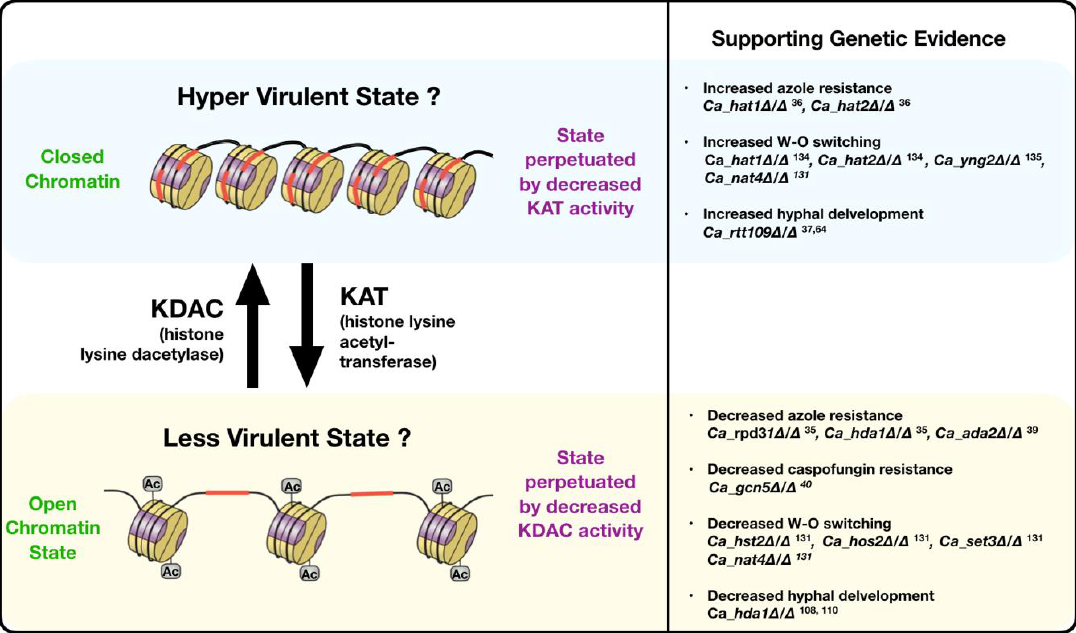
Figure 3. Simplified model of the role of histone acetylation in C. albicans virulence. A summary of the genetic studies in C. albicans that are consistent with a model whereby a decrease/loss in specific histone acetylation marks lead to a hypervirulent state, whereas an increase in histone acetylation is associated with the attenuation of virulence. All examples are from studies in C. albicans specifically. This model is the rationale for why (K) deacetylase (KDAC) inhibitors are potentially useful anti-fungal drugs. (Ac = acetyl group).